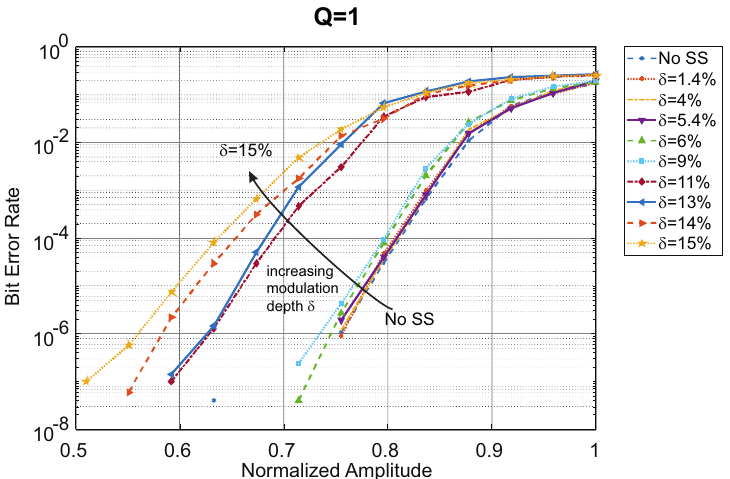
Figure 11. Bit error rate of a communication channel corrupted by SS-modulated EMI under weakly resonant coupling ( Q = 1) vs. EMI normalized r.m.s. amplitude at different modulation depth δ .